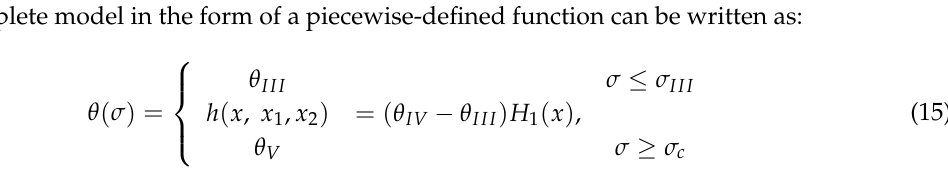
Table 3. Intercept values for stage III and IV .